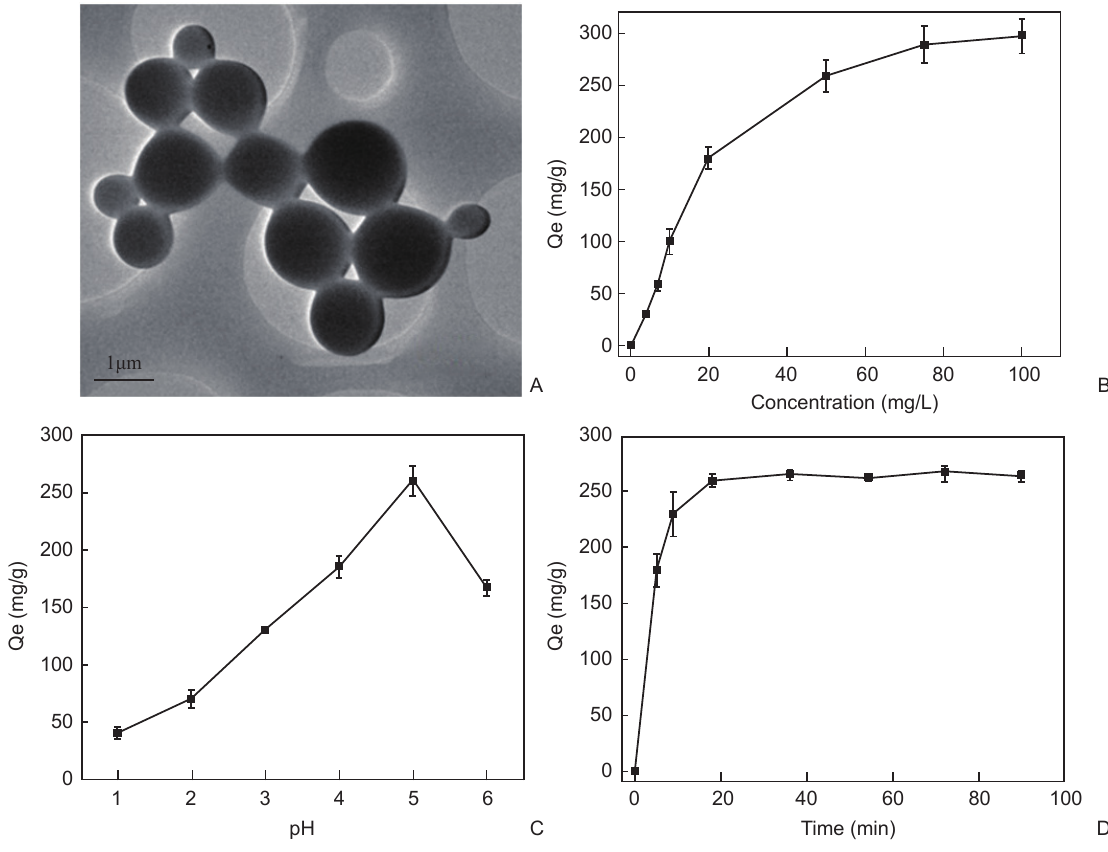
Figure 2 Characterization of PLA@GO microbubbles by TEM and the determination of Pb 2+ concentration by ICP-AES. (A)Transmission electron microscopy image of PLA@GO microbubbles; (B) Effect of initial amount of lead ion on PLA@GO microbubble adsorption; (C) The effect of pH value on the adsorption capacity of PLA@GO microbubbles; (D) The effect of adsorption time on the adsorption capacity of PLA@GO